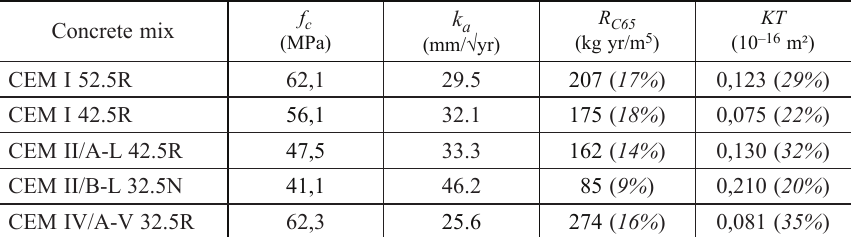
Table 6. Concrete experimental characterization. Tests results at the age of 28 days – mean values (coefficient of variation – CoV for R C 65 and KT ) Concrete